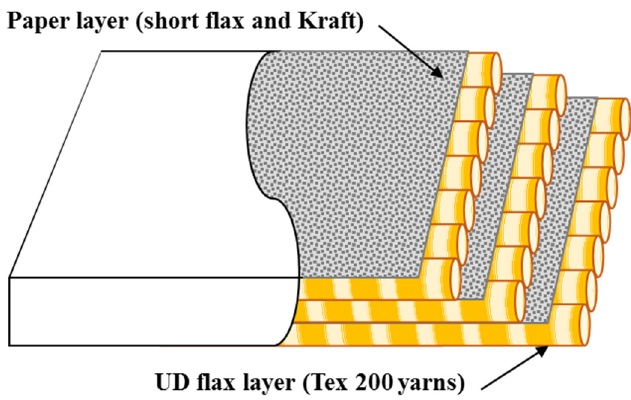
Figure 2. Stacking sequence of reinforcement sample.